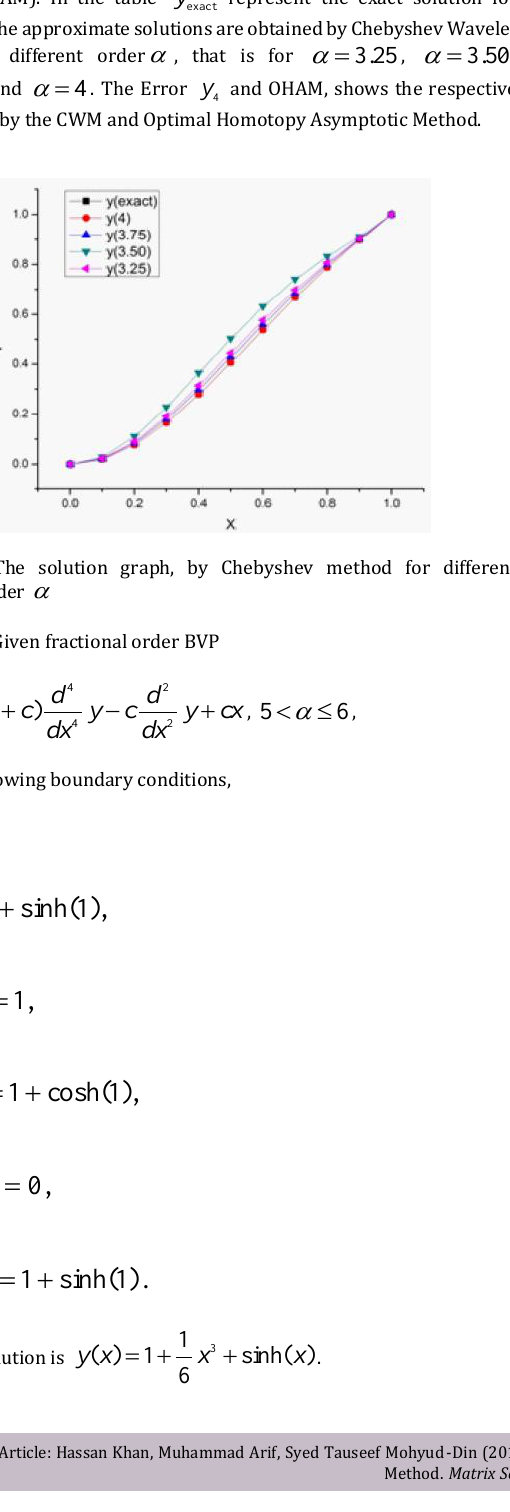
Figure 2: The Chebyshev solutions graph for the fractional differential equations of different order .  Table 2: The numerical results for Problem 2 for different fractional order 